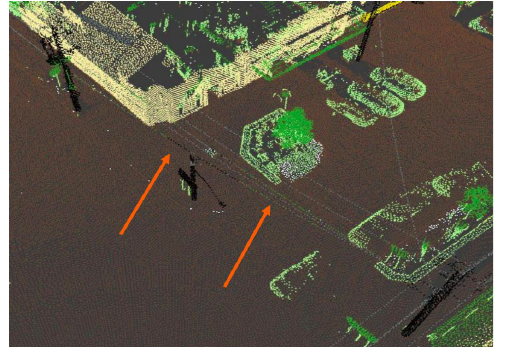
Figure 4. Failure to classify cables could be caused because of the uncertainty in the collecting data (incomplete capture), faulty segmentation as well as classification